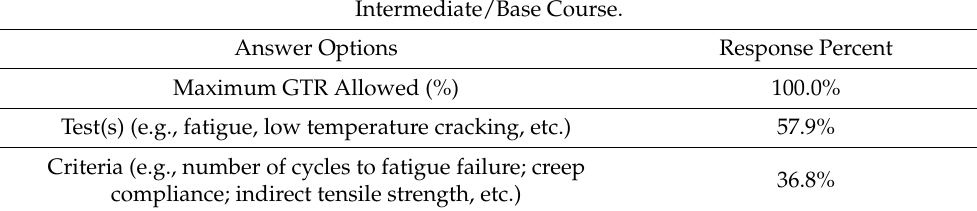
Table 17. Criteria used for Base/Intermediate Course Mixes Containing GTR. Please Specify Test(s) and Criteria Used to Set the Maximum GTR Content (%) Limit in Intermediate/Base